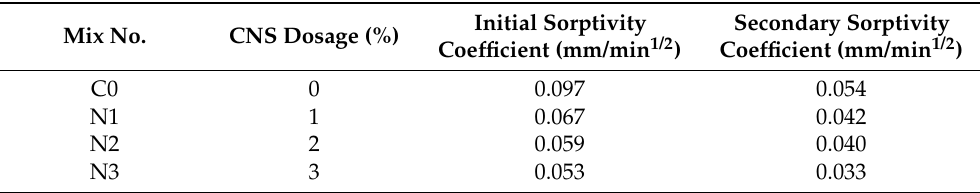
Table 4. Initial and secondary sorptivity coefficient of mortars.